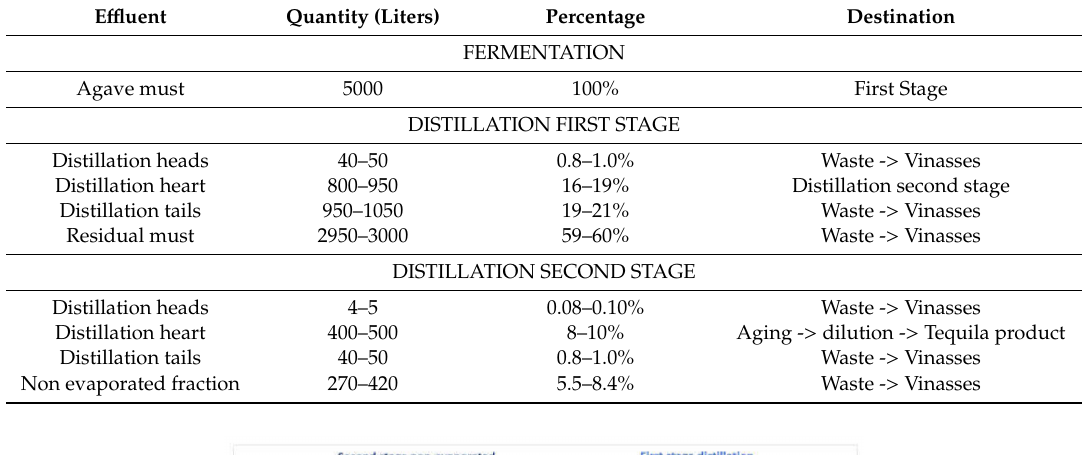
Table 2. Volume balance for still distillation process for 1 batch of 5000 L fermented agave must.